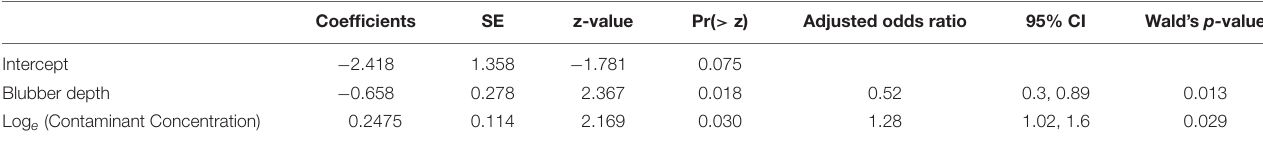
TABLE 2 | Logistic regression model investigating probability of cancer in relation to blubber contaminant concentrations (log e [sum contaminant concentrations, ng g − 1 lipid weight]) after controlling for blubber depth (glm[CaseControl ∼ BlubberDepth] + Log e [ContaminantConcentration], n =